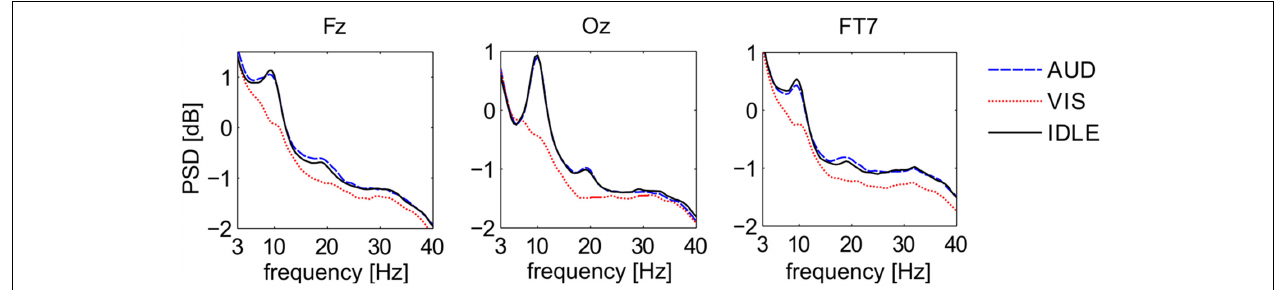
FIGURE 6 | Power Spectral Density of three EEG signals at Fz, Oz, FT7 for three different conditions. Depicted are averages for the classes AUD (blue), VIS (red), and IDLE (black).